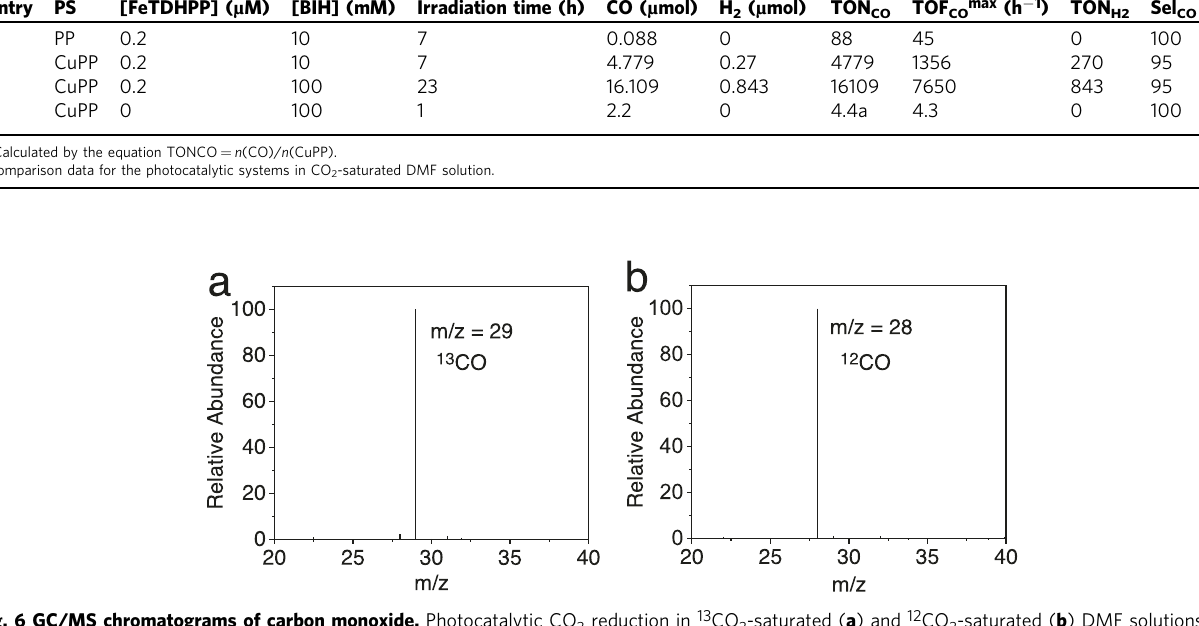
Table 1 Control and other photocatalytic CO 2 -reduction experiments.